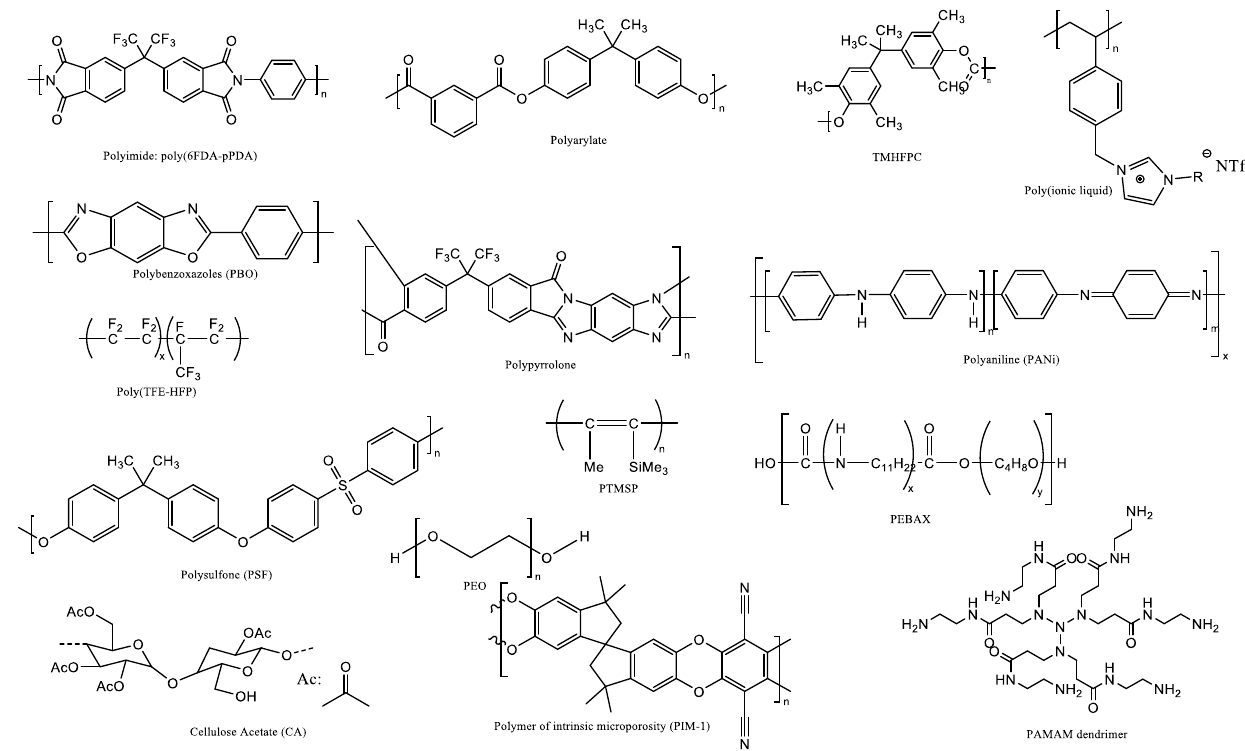
Scheme 1. Typical polymer examples that are used for CO 2